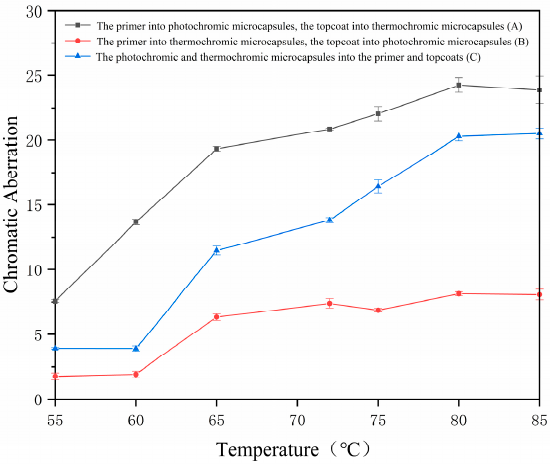
Figure 2. Influence of temperature on chromatic aberration of coating with different coating methods.